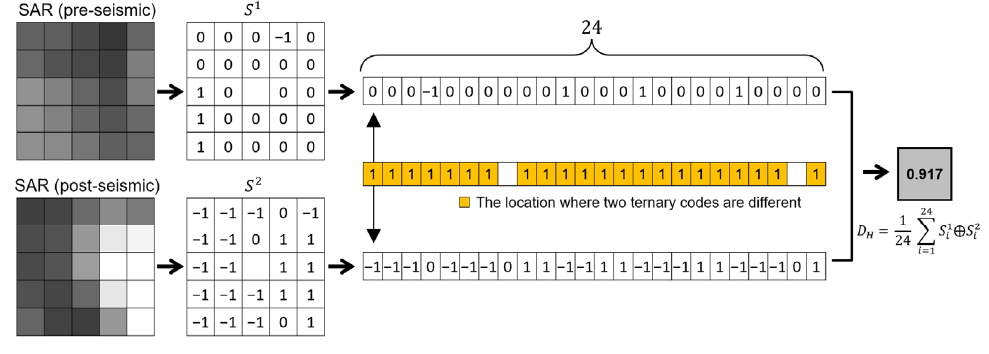
Figure 5. The process of calculating the Hamming distance of each pixel.